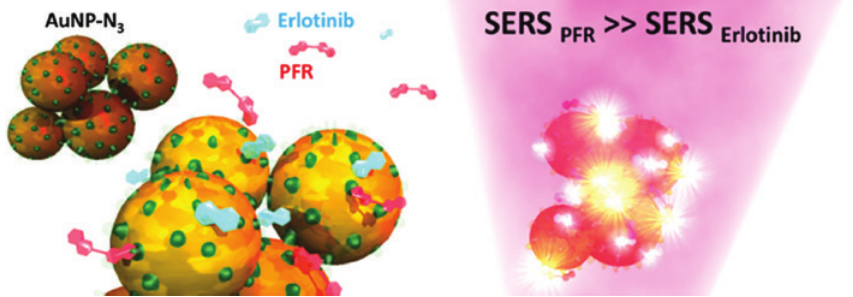
Figure 3: Schematic working principle of SERS mediated monitoring of the anti-cancer drug erlotinib. Erlotinib and PFR compete for the azide-groups on the surface of the functionalized Au NP. In common applications, erlotinib levels are low and the strong Raman scatterer PFR dominates on the surface of the Au NP clusters. The resulting intense SERS signal is negatively proportional to the target drug concentration. Adapted from Litti et al. [83], reproduced with the kind permission of Elsevier, Copyright (2019)